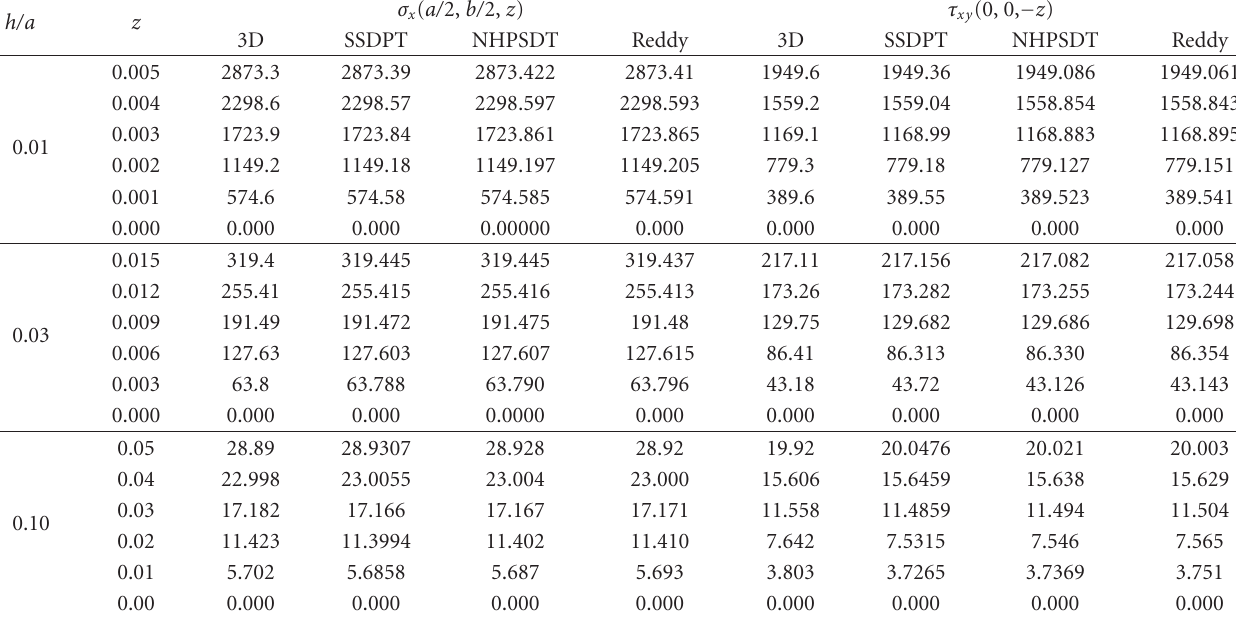
Table 3: Distribution of stresses across the thickness of isotropic homogenous plates ( E ; a/b = 1 and k = 0). h/a